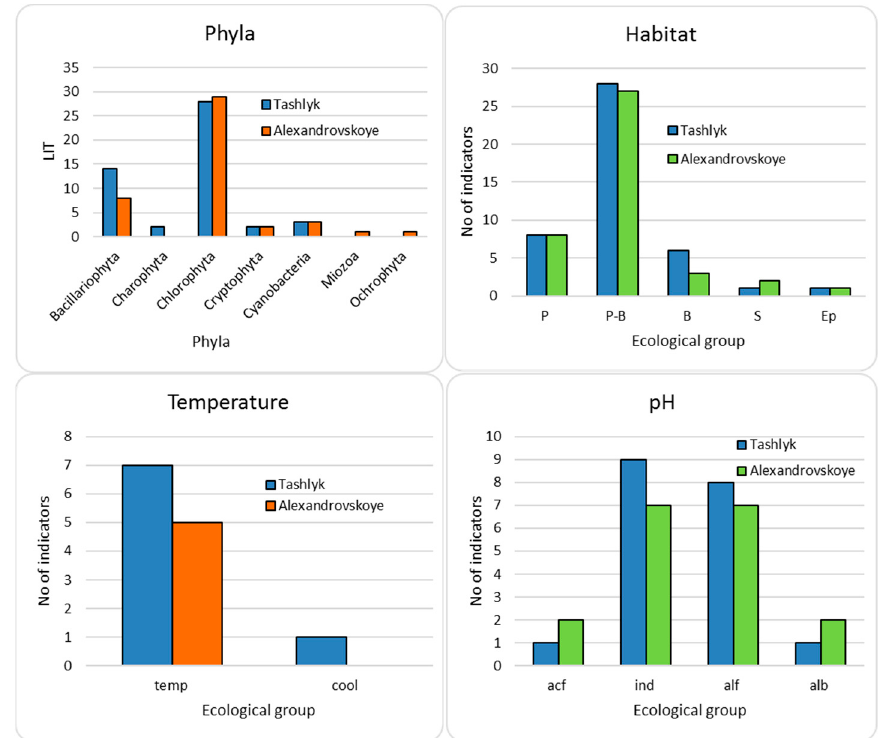
Figure 6. Distribution of taxonomic content (LIT) and indicators of habitat, water temperature and pH for phytoplankton communities in two reservoirs of the Southern Bug River, Tashlyk and Alexandrovskoye reservoirs. Ecological groups on the x -axis are placed in order of increasing indicator variable value. Abbreviations of ecological groups are given in Table 3.